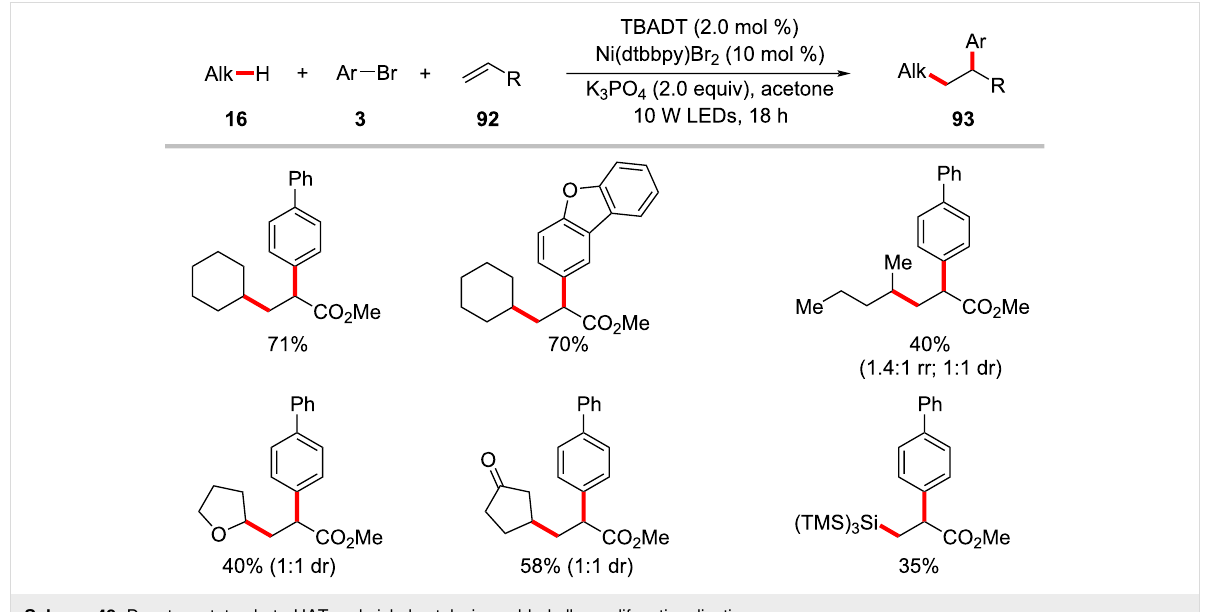
substrates 16 , and aryl bromides 3 . In general, the products were obtained in moderate to good yields and good regioselec- tivities (Scheme 49) [141]. The detailed experimental and computational studies highlight the involvement of hydrogen bonding assistance during the radical addition to olefine. The